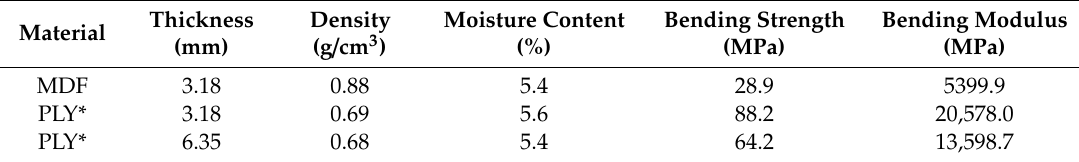
Figure 1. The structure of the Taiji honeycomb core: ( a ) three-dimensional picture; ( b ) two-dimensional picture ( l = 9.53 mm and 2 θ = 2 π ). Table 1. Properties of the medium-density fiberboard (MDF) and plywood (PLY) used in the outer layers (skins).